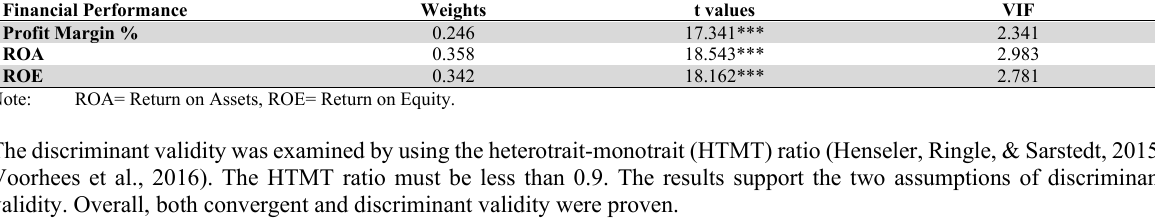
Descriptive and Measurement model of second level constructs (formative) Financial Performance Weights t values VIF Profit Margin %